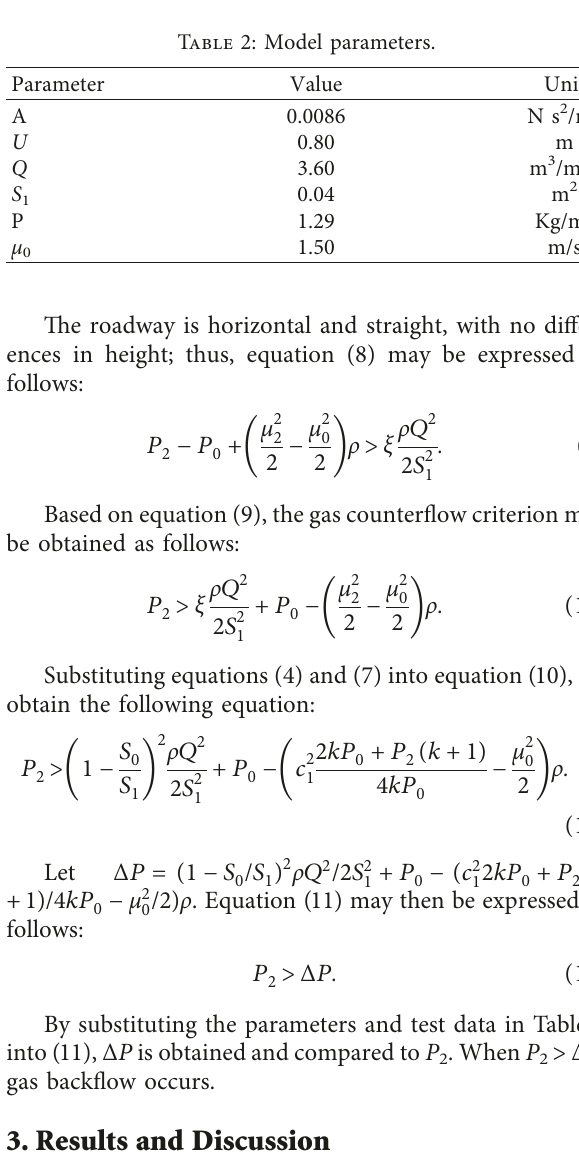
Figure 2: Physical experimental system. (a) Schematic of the physical experiment system. (b) Experimental system diagram.